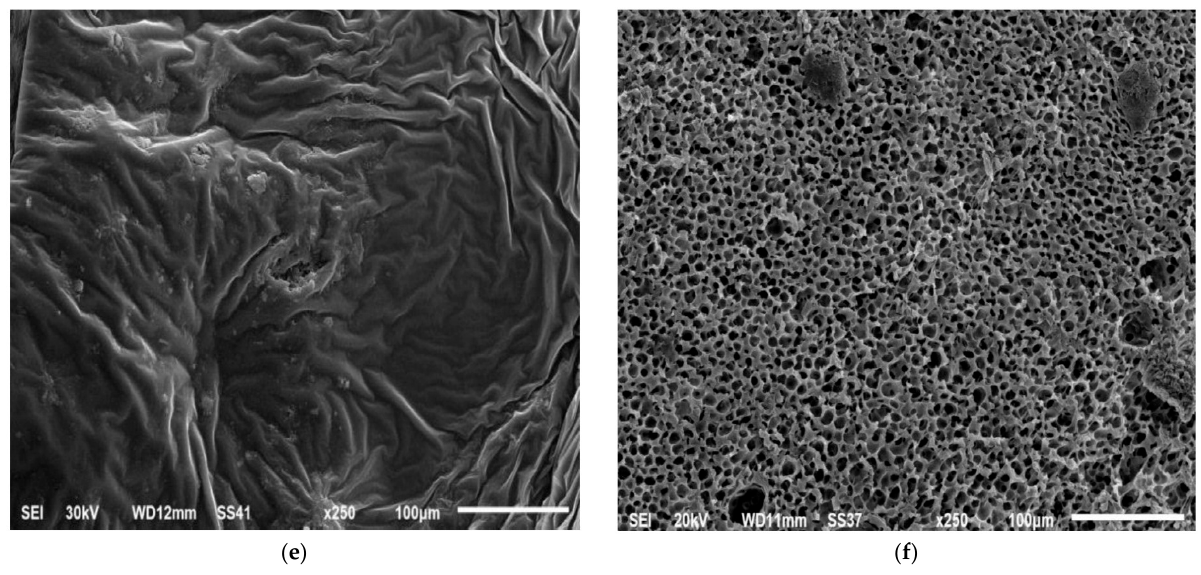
Figure 8. SEM study of optimized ISGI formulation ( a ) external surface after 0 day ( b ) internal structure after 0 day ( c ) external surface after 1 day ( d ) internal structure after 1 day ( e ) external surface after 10 days ( f ) internal structure after 10 days.